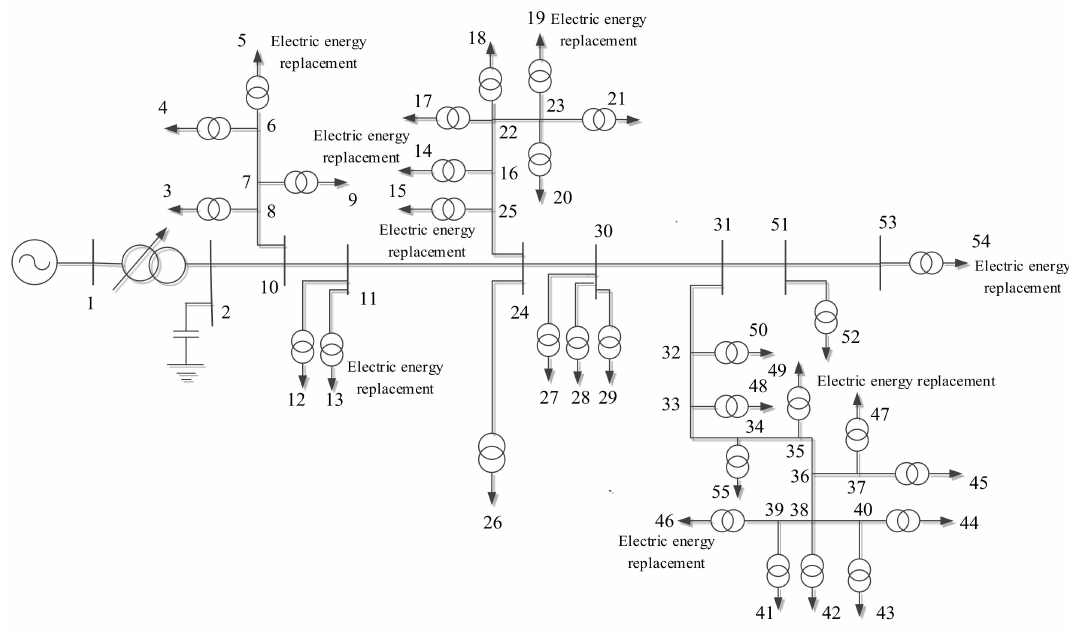
Figure 3. A 55-bus urban distribution network of 10 kV.